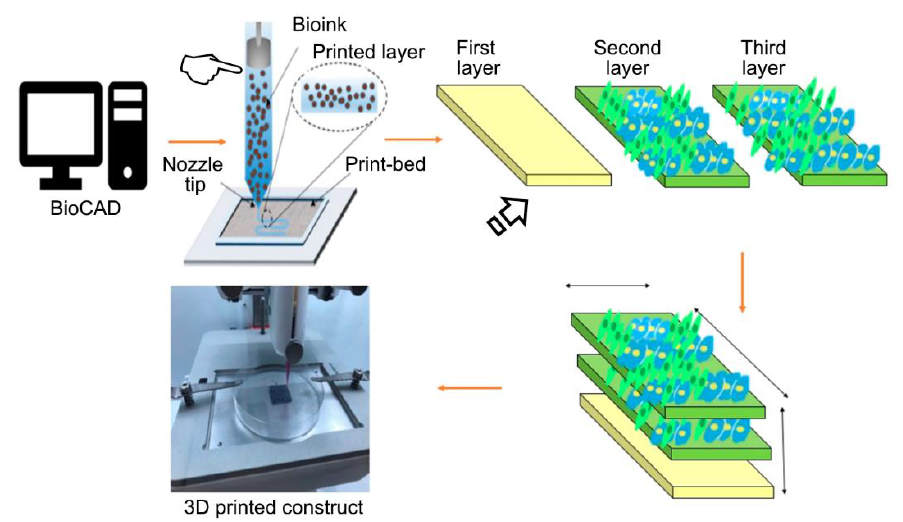
Figure 2. The most important part of this printing technique is the bioink (pointer), which is the matrix material that provides a proper environment for the transmission of cues and signals for the tissue formation and cellular function. To print 3D soft tissue-like structures, cells are either mixed with bioink and printed or printed separately as cell suspensions onto bioink. The 3D construct is assembled in an additive manner by printing layer by layer [34] (arrow). Figure reproduced and adapted from Hafezi et al. (2020) [36]. Copyright MDPI, 2020.